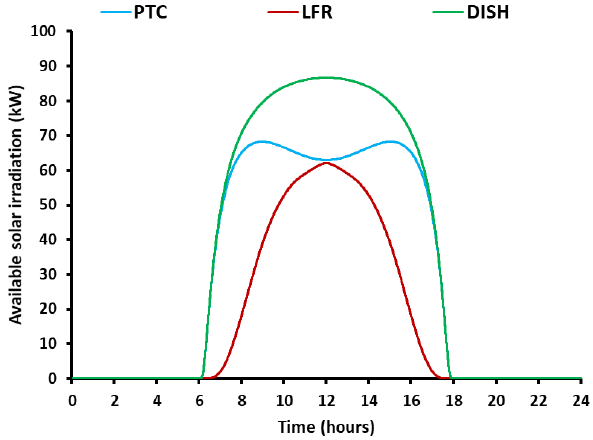
Figure 5. Daily variation of the available solar irradiation for the three collectors in June.